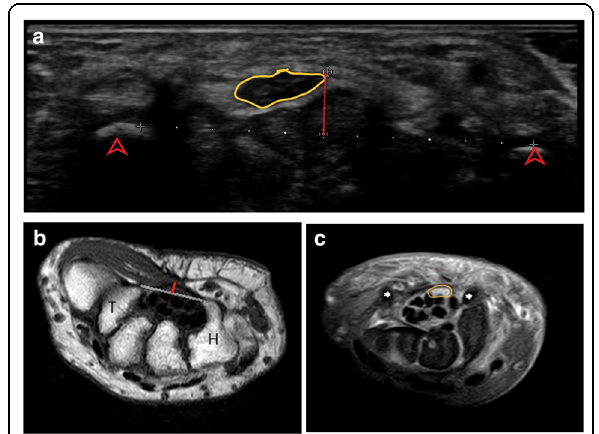
Fig. 4 a Median nerve is hypoechoic (yellow outline) at the level of the carpal tunnel inlet (arrowhead) with bowing of the flexor retinaculum (red line) at the inlet measuring 3.4 mm in this patient with CTS. b Axial T1-weighted MR image at the carpal tunnel outlet (T- trapezium, H- hamate) shows bowing of the flexor retinaculum (red line), 2.8 mm in this patient with CTS. c Hyperintense median nerve (yellow outline) is seen on PD FS axial MR image at the carpal tunnel inlet (asterix) in the same patient with CTS